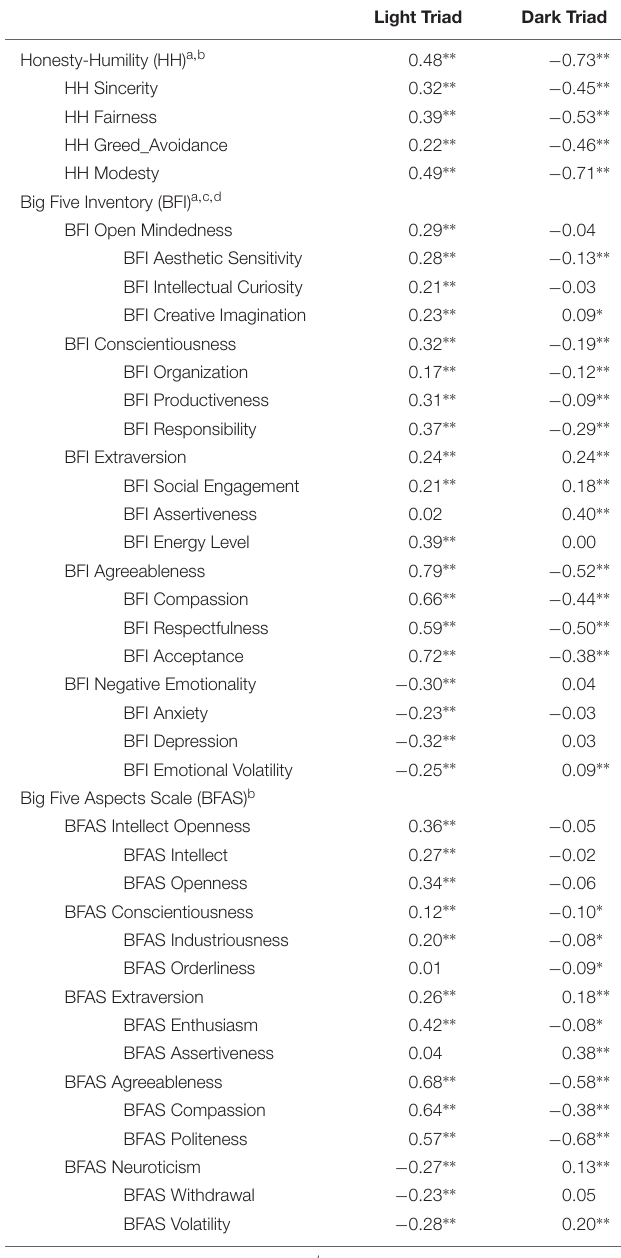
TABLE 6 | Correlations between personality and light vs. dark triad. looking at the BFI Big Five traits, Agreeableness remained Light Triad Dark Triad